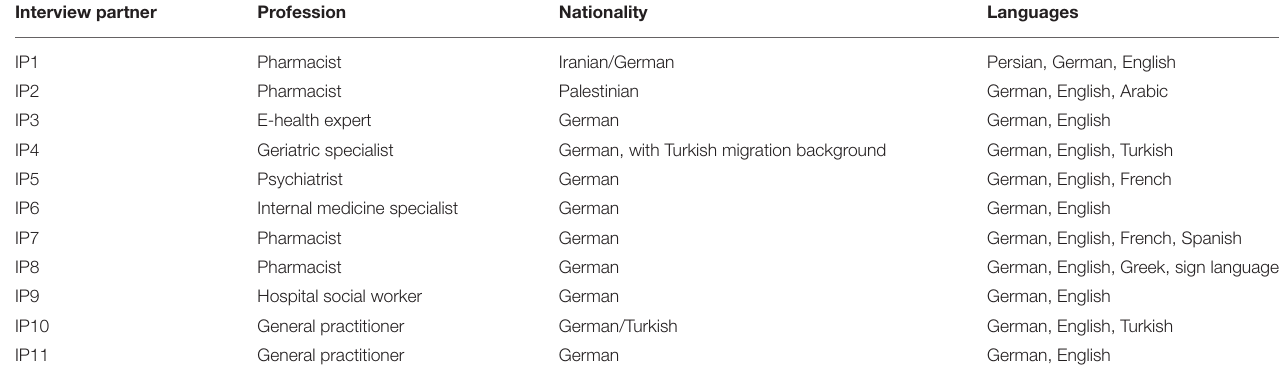
TABLE 1 | Overview of participant